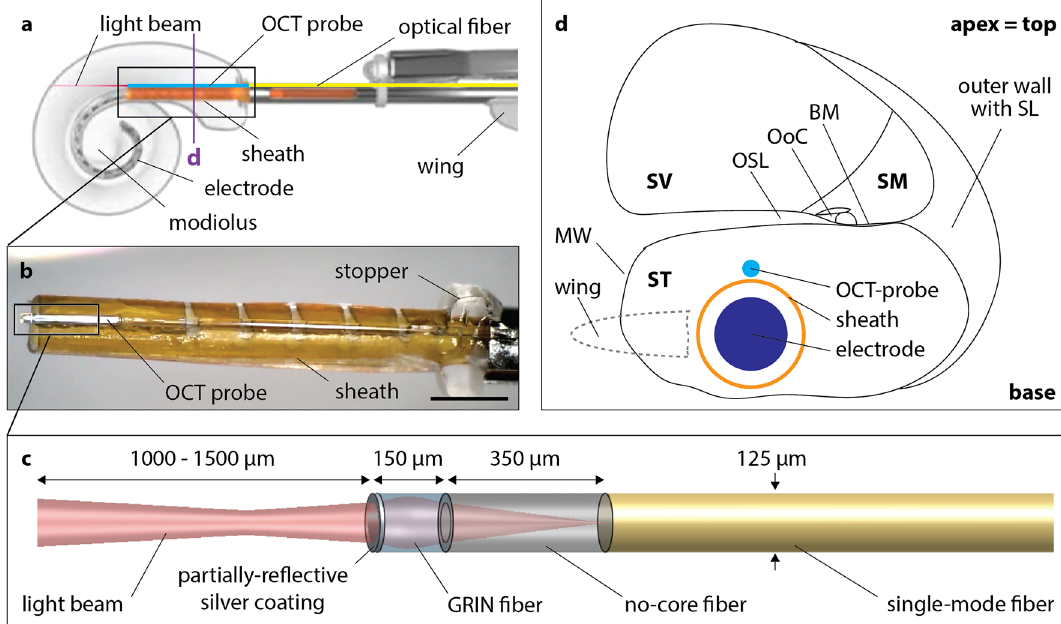
Figure 1. Design and intracochlear position of the optically-guided sheath. ( a ) A schematic shows the optically-guided sheath and the electrode within the cochlear spiral, whereby the electrode is positioned adjacent to the modiolus (original schematic was adapted with permission, courtesy of Cochlear Limited). Note the position of the sheath wing, pointing towards the modiolus. The purple line indicates the position of the schematic cross-section depicted in ( d ) with respect to the cochlear spiral. ( b ) Microscopic photograph of the optically-guided sheath. ( c ) Schematic of the OCT probe together with its beam path. ( d )